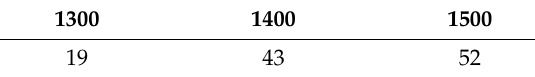
Table 3. Density and flowability powders prepared with different sintering temperatures.